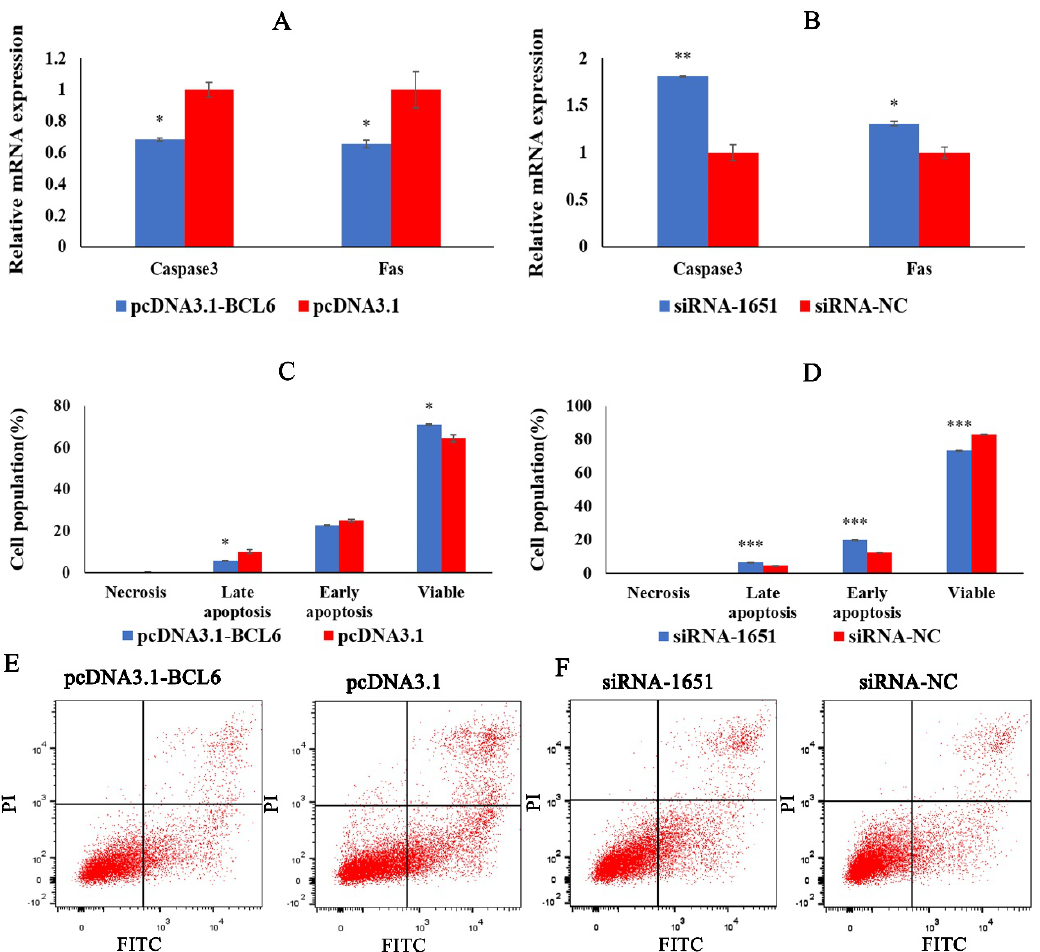
Figure 7. BCL6 gene inhibits chicken myoblasts’ apoptosis. ( A , B ) The relative expression of apoptosis marker genes Caspase3 and Fas after transfection with pcDNA3.1-BCL6 and siRNA-1651. ( C , D ) Statistical chart of FCM test results. ( E , F ) The scatter plot of the FCM results after transfection with pcDNA3.1-BCL6 and siRNA-1651. In all graphs, the results are shown as mean ± SEM (standard error of the mean) ( n = 3). * p < 0.05, ** p < 0.01, *** p <